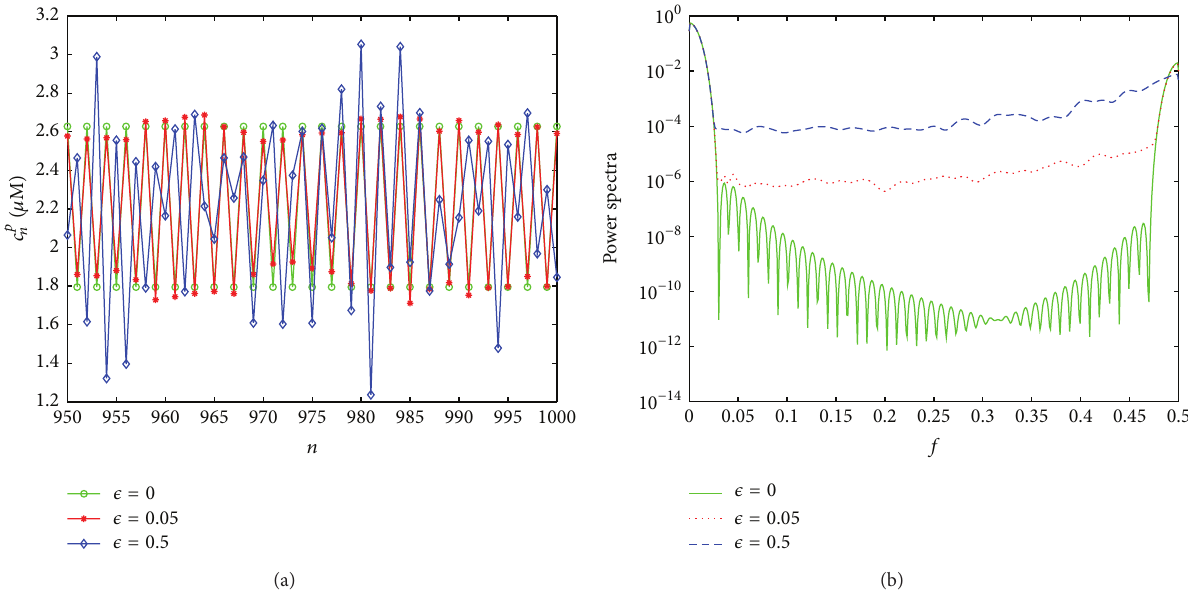
Figure 5: (a) Time series of system (11) for different noise intensities 𝜖 = 0, 𝜖 = 0.05 , and 𝜖 = 0.5 , respectively, where the total calcium 𝑐 𝑡 = 1.4 and the other parameters are the same as Figure 1(a). (b) Power spectra corresponding to the time series in